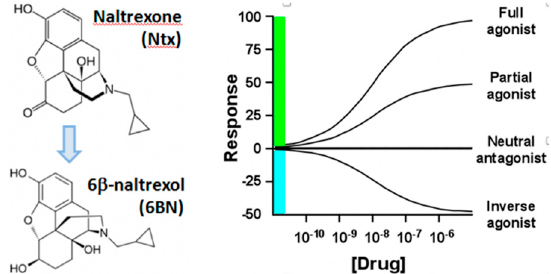
Figure 2. Metabolic conversion of naltrexone to 6BN, and hypothetical dose–response curves for agonists and antagonists. Etorphine is considered a full agonist and morphine a partial agonist, while